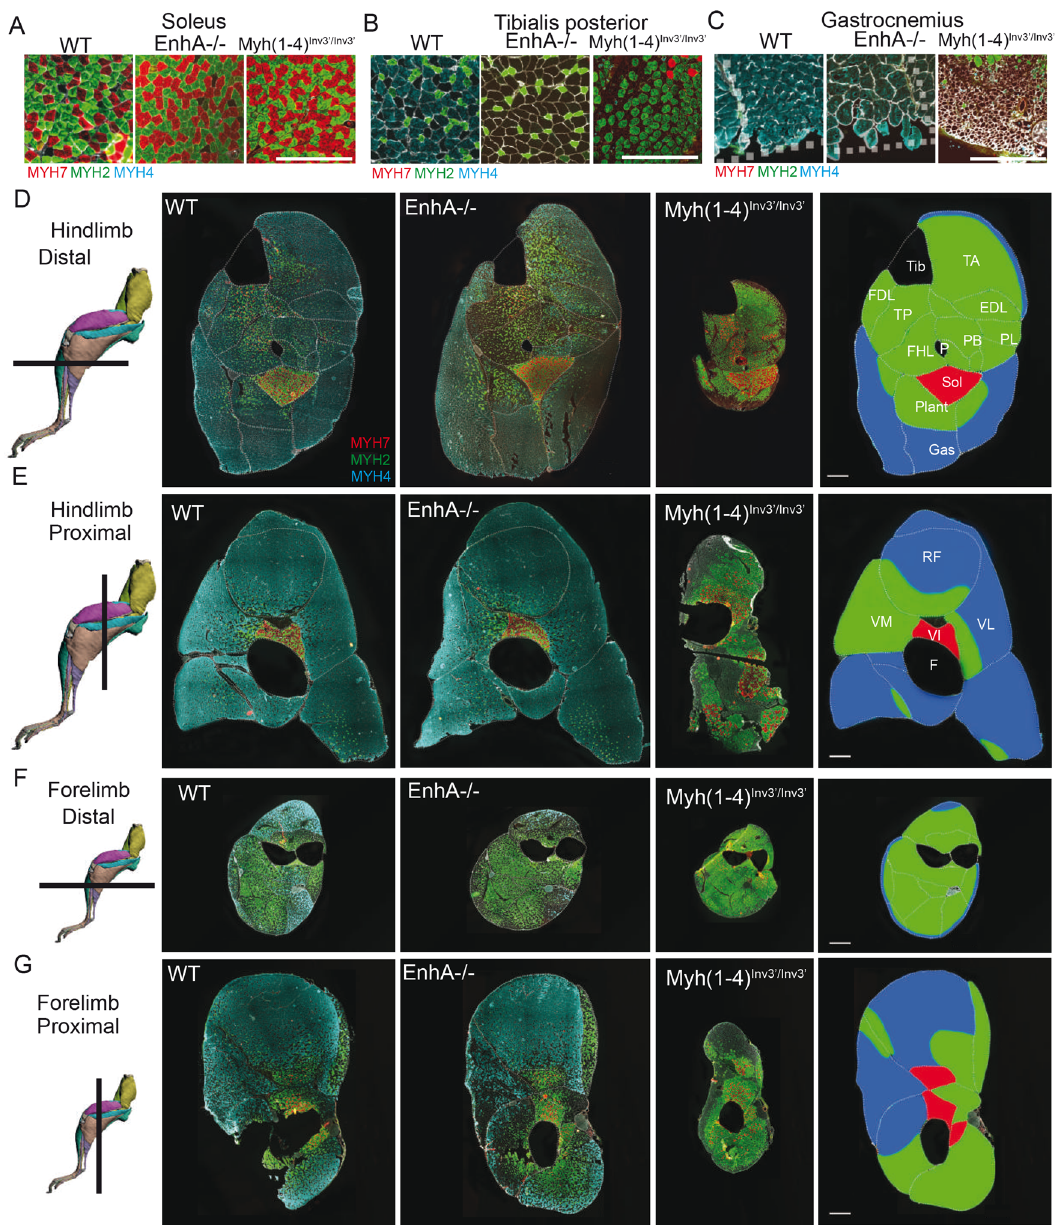
Fig. 6 MYH expression established different groups of limb skeletal muscles in mutant animals. A – C Immunostaining against MYH7 (red), MYH2 (green), and MYH4 (blue) in WT, EnhA − / − , and Myh(1 – 4) Inv3 ′ / Inv3 ′ adult mice. The soleus ( A ) is not affected in these mutant mice. In the Tibialis posterior ( B ), the expression of MYH4 is lost in EnhA − / − , and in Myh(1 – 4) inv3 ’ /inv3 ’ whereas an upregulation of MYH1 is observed in EnhA − / − mice and an upregulation of MYH2 in Myh(1 – 4) Inv3 ′ / Inv3 ′ mice. In Gastrocnemius ( C ), the peripheral fi bers of Myh(1 – 4) Inv3 ′ / Inv3 ′ mice present a severe atrophy. In contrast these fi bers are not affected in EnhA − / − mouse. D Comparison of the phenotypes of adult muscles in EnhA − / − and in Myh(1 – 4) Inv3 ′ / Inv3 ′ allowed classi fi cation of distal hindlimb muscles in three major categories. The fi rst group is shown in red corresponded to the soleus that is not affected. The second group shown in green corresponded to muscles affected in EnhA − / − and Myh(1 – 4) Inv3 ′ / Inv3 ′ mutants. The third group shown in blue corresponded to muscles strongly affected in Myh(1 – 4) Inv3 ′ / Inv3 ′ but not in EnhA − / − mutants. E Same as D in the proximal part of the hindlimb. F Same as D in the distal part of the forelimb. G Same as D in the proximal part of the forelimb. For D , scale bar: 100 μ m. D – G : drawings of hindlimbs and forelimbs are from Charles et al. 42